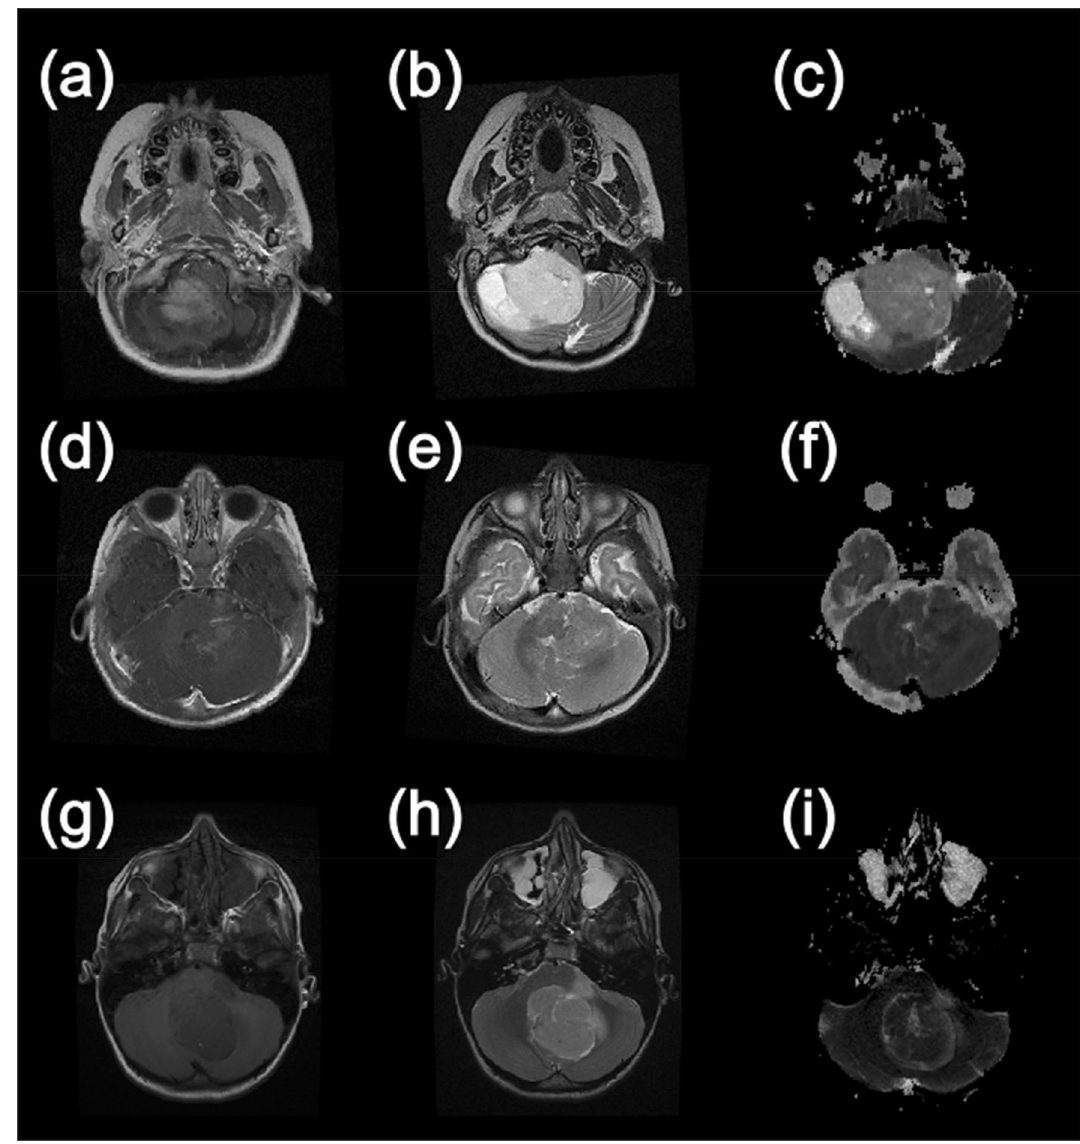
Figure 1. Example MR images from paediatric brain tumour patients. This first column shows T1-weighted images following the injection of gadolinium contrast agent. The second column shows T2-weighted images and the final column shows apparent diffusion coefficient maps calculated from diffusion-weighted images. ( a – c ) are taken from a patient with a Pilocytic Astrocytoma, ( d – f ) are from a patient with an Ependymoma and ( g – i ) were acquired from a patient with a